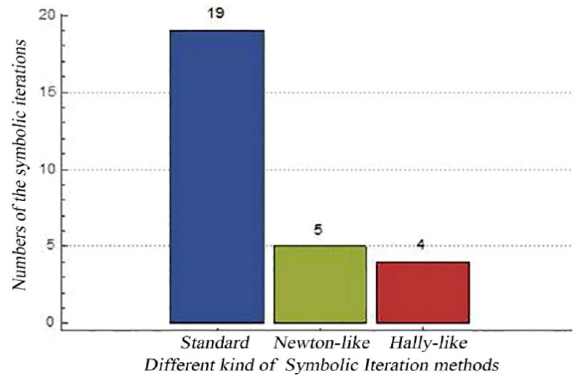
Figure 2. Number of iterations through standard SICAA method, Newton-like SICAA method and Halley-like SICAA method (double precision), until the i th iterative coefficients of e n ( n = 1, 2, . . . , 18 ) and the ( i − 1 ) th iterative coefficients of e n ( n = 1, 2, . . . , 18 ) are the